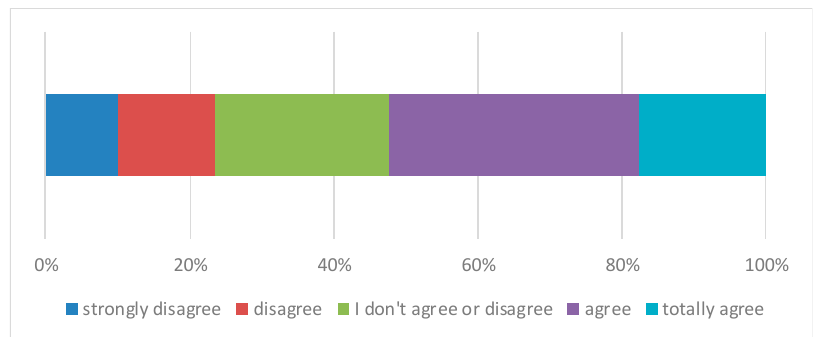
Figure 9. Need for a bridging course before entering university.